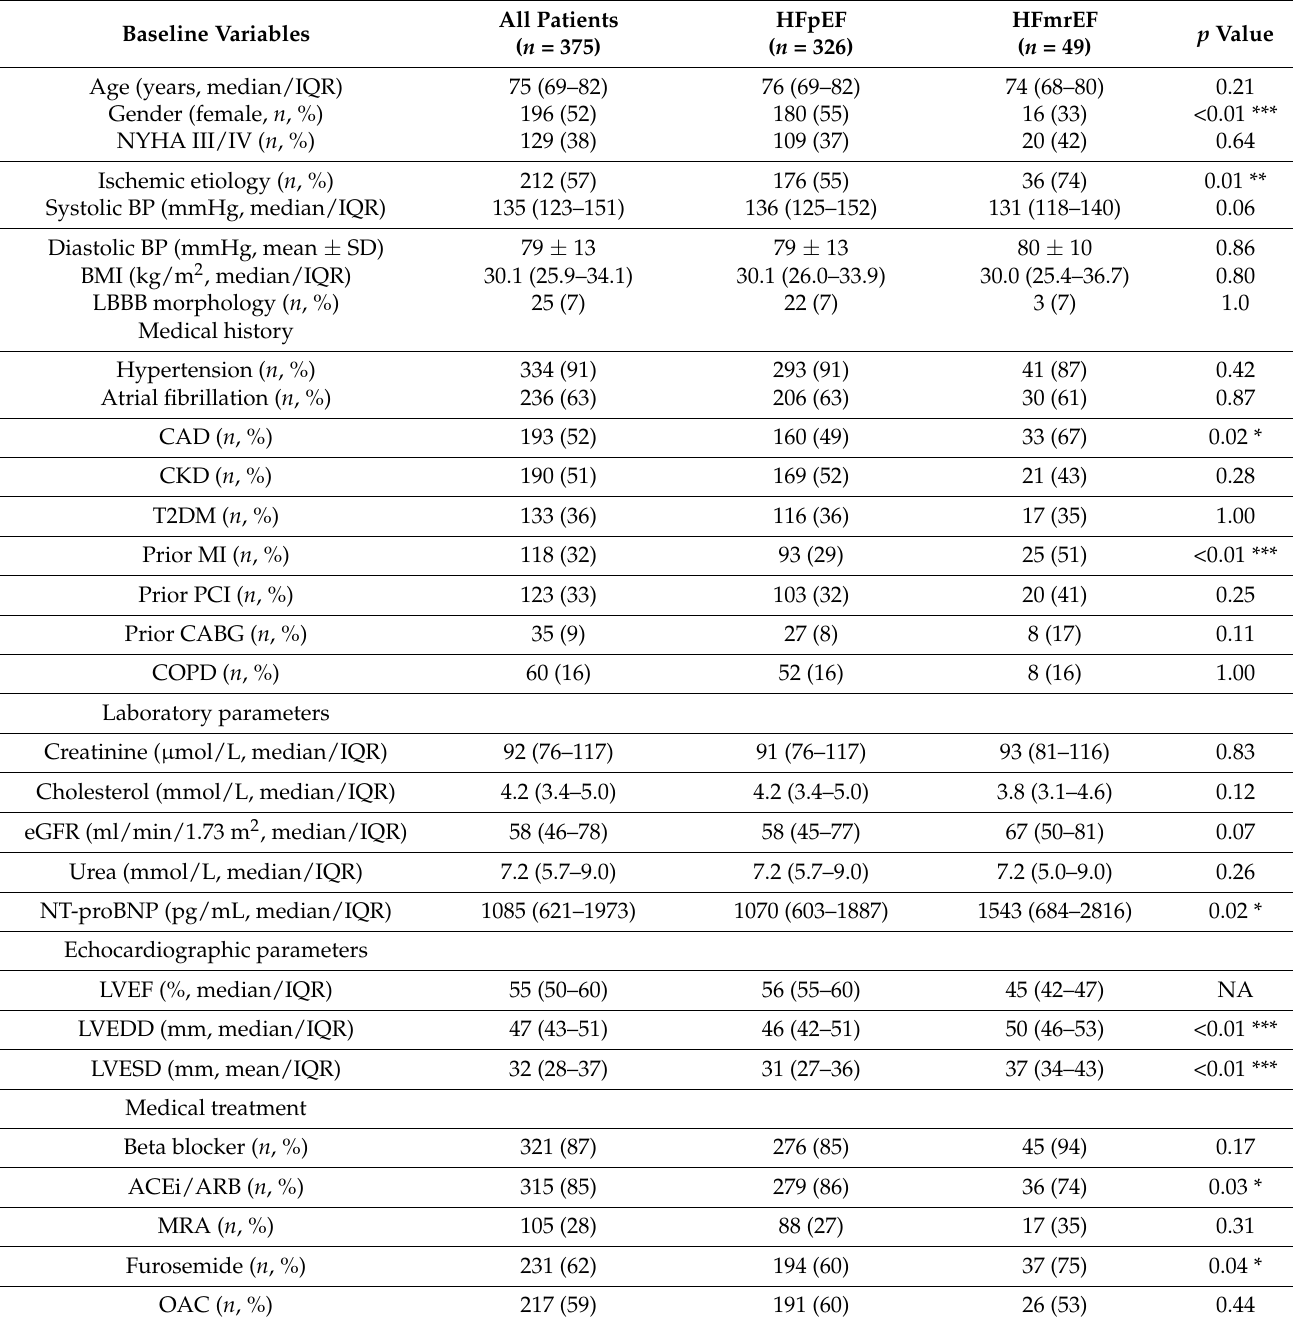
Table 1. Baseline clinical characteristics of heart failure patients with preserved (HFpEF) and with mildly reduced (HFmrEF) ejection